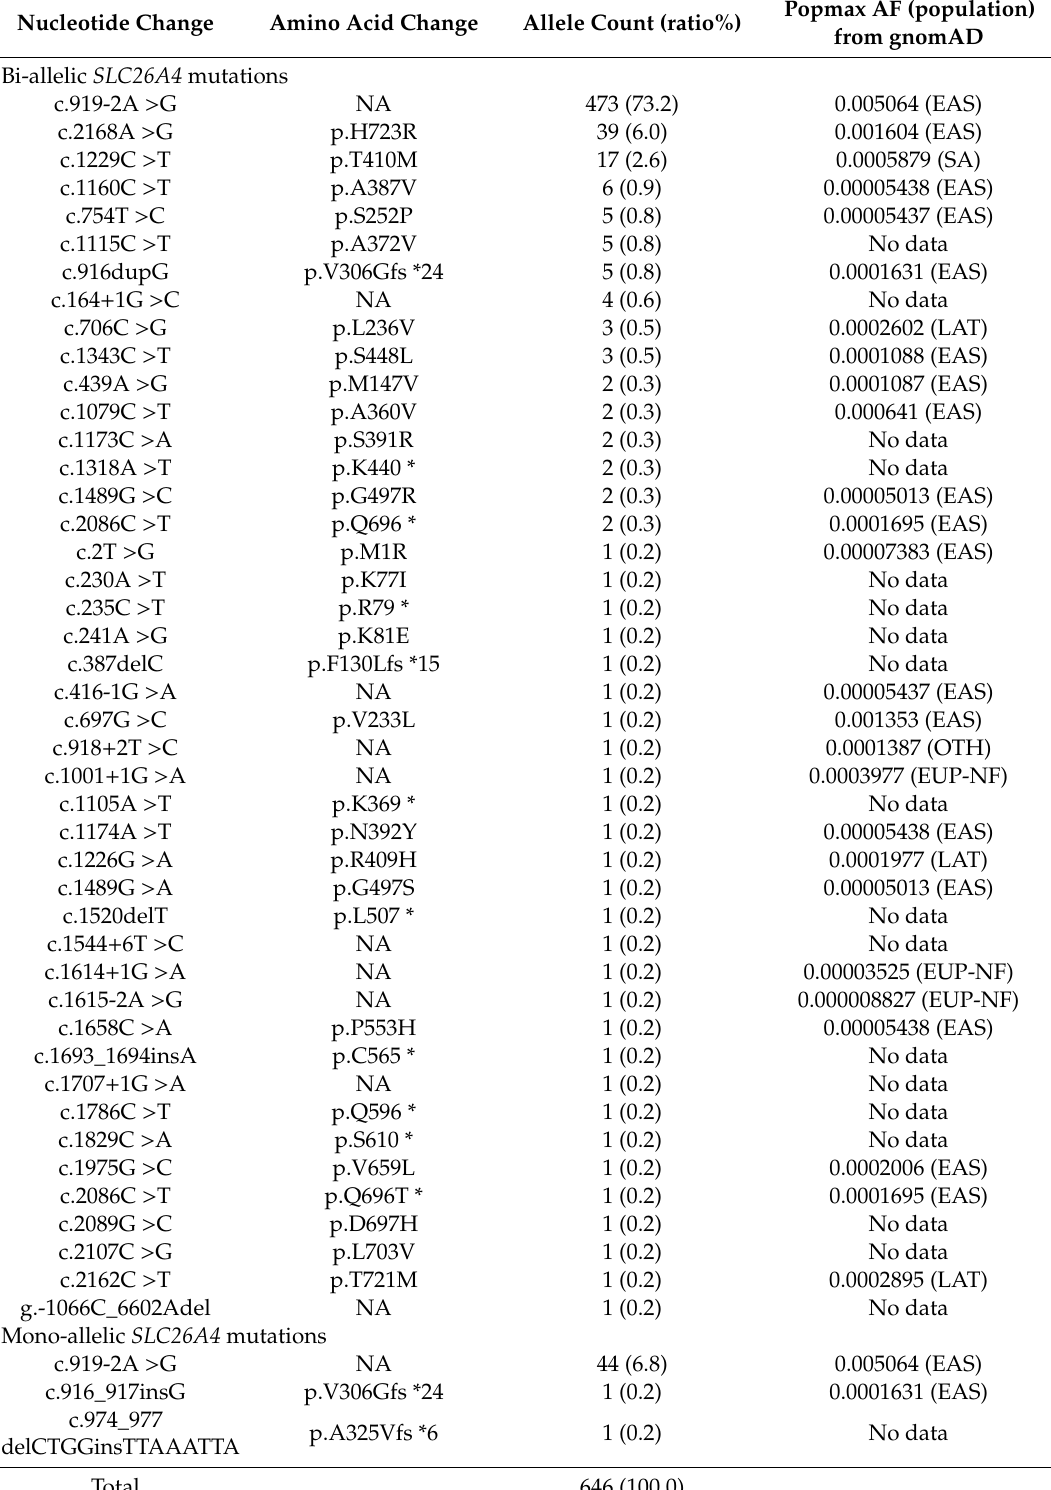
Table 3. SLC26A4 mutations detected in 346 Taiwanese families with DFNB4 /